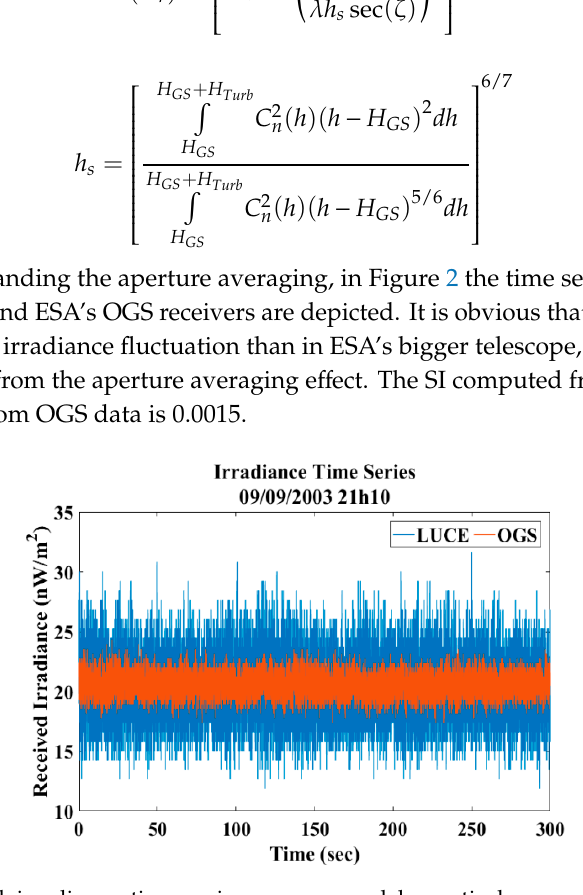
Figure 2. Received irradiance time series as measured by optical ground station (OGS) and LUCE terminals.